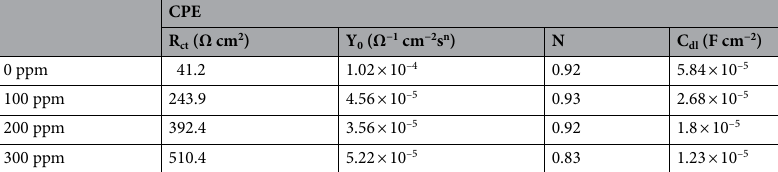
Table 2. The electrochemical parameters extracted from EIS data of MS specimens dipped for 3 h in hydrochloric acid solution at different concentrations of GSE at 25 °C.